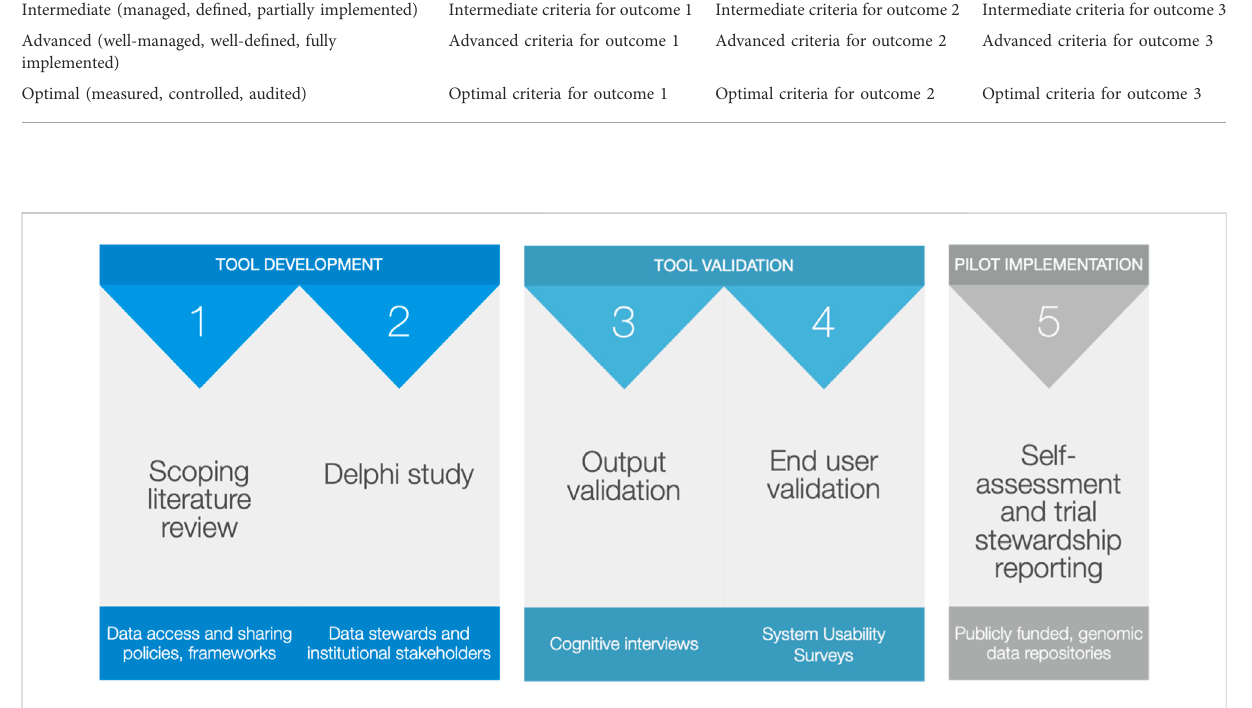
FIGURE 1 Step-by-step outline of a protocol to develop, validate and pilot the implementation of a stewardship maturity matrix tool to track progress on human genomic data stewarded in the